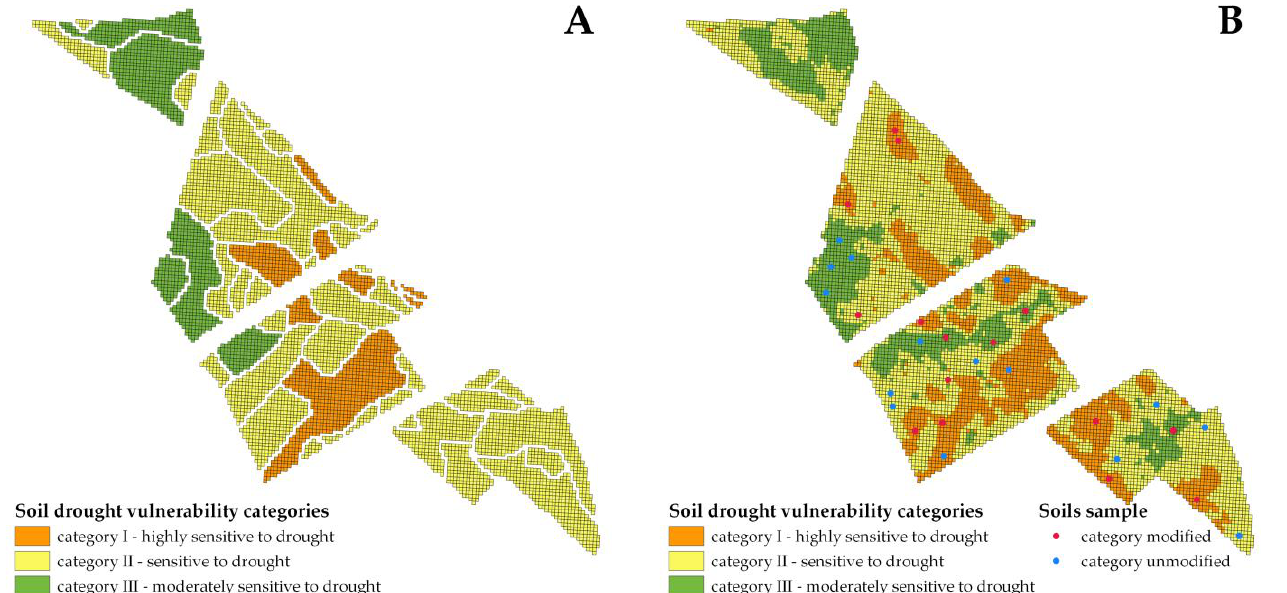
Figure 5. Drought vulnerability polygons of soils before reclassification ( A ), after reclassification with soil sampling locations ( B ).